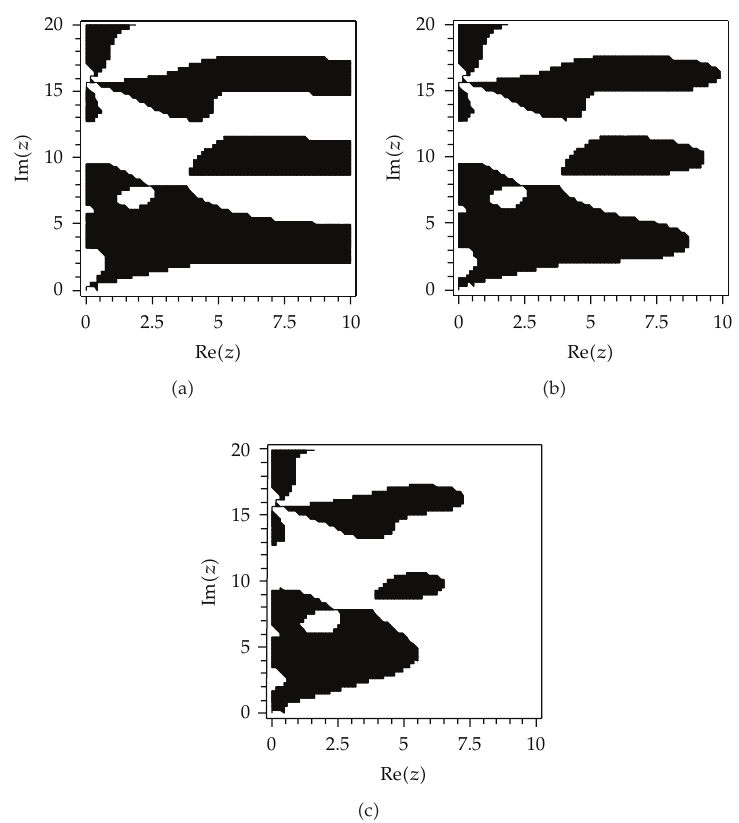
Figure 2: Stability region of the exponentially fitted method which is based on the lower-order formula of EHM6 (cid:3) 4 (cid:4) method. (cid:3) a (cid:4) (cid:3) H (cid:6) 0 . 5, z ∈ C (cid:4) , (cid:3) b (cid:4) (cid:3) H (cid:6) 1, z ∈ C (cid:4) , (cid:3) c (cid:4) (cid:3) H (cid:6) 2, z ∈ C (cid:4)